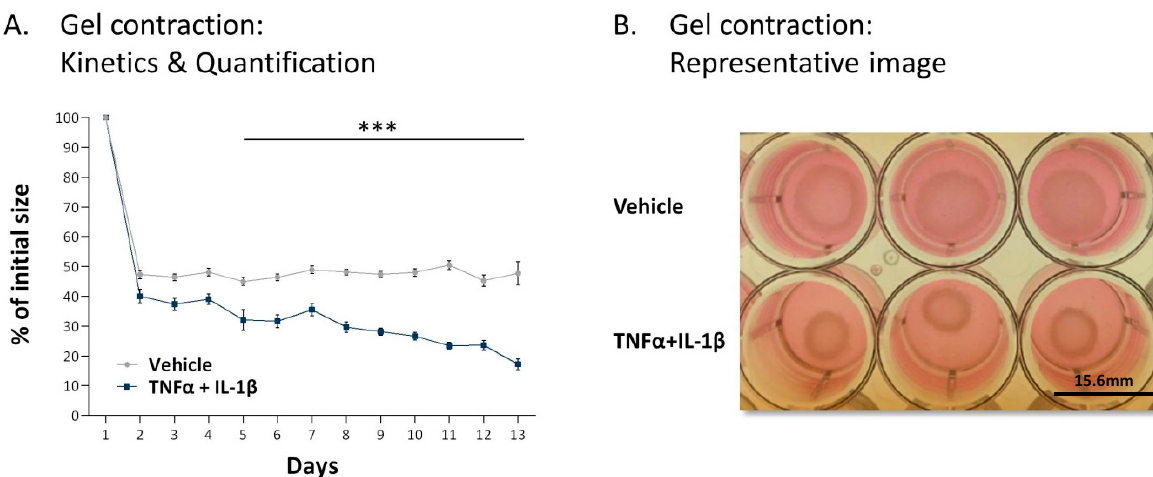
Figure 4. Following persistent stimulation of MSCs with TNF α + IL-1 β , the resulting CAF-like cells express typical CAF functions. Human MSCs were exposed to persistent TNF α + IL-1 β stimulation (concentrations as in Figure 1) or to vehicles, generally for 14–18 days. The figure demonstrates the results of a collagen contraction assay, in which the change in collagen gel size was determined along the process. ( A ) Kinetics analyses of changes in collagen gel diameter compared to original gel size, measured by ImageJ. The average ± SEM of 5 independent experiments is demonstrated. *** p < 0.001. ( B ) An image from a representative experiment out of n = 5 is presented. Three wells are demonstrated for each treatment. The photo was taken at day 10 of the collagen contraction assay. Bar, 15.6 mm.